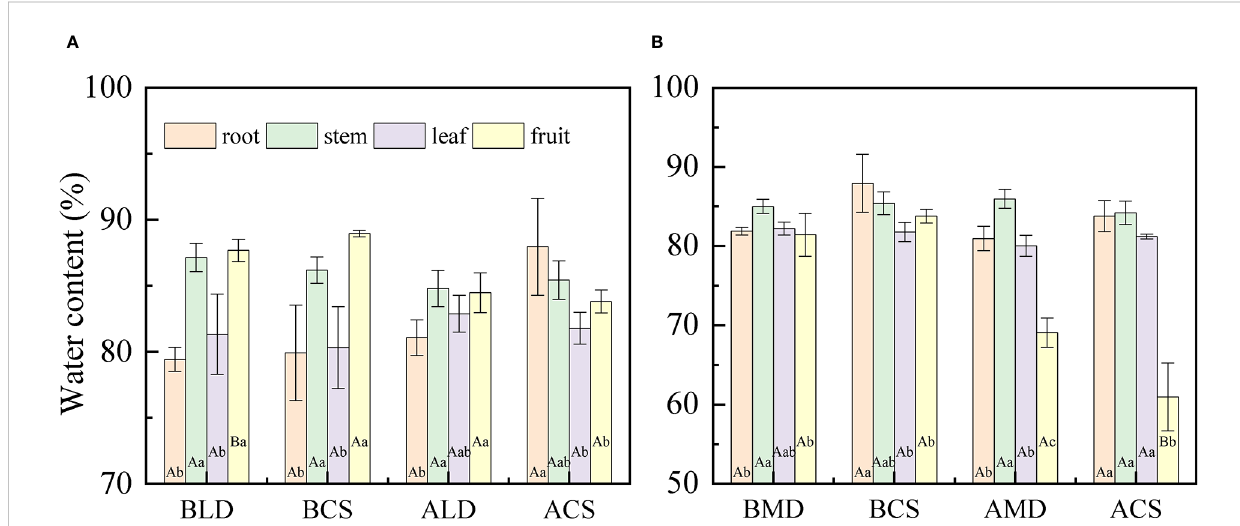
FIGURE 3 Comparative analysis of the water content of each component organ under different drought conditions and after rehydration. (A, B) are the comparative analysis of the water content of each component organ in light drought and moderate drought, respectively. Error bars represent standard deviations (n = 3), different capital letters indicate signi fi cant difference between groups (p< 0.05), and different lowercase letters indicate signi fi cant difference between different component organs of the same group (p< 0.05). BLD, BCS, ALD, and ACS represent before light drought, control group in the same period during light drought, after rehydration in light drought, and control group in the same period during after rehydration, respectively. Similarly, BMD, BCS, AMD, and ACS represent before moderate drought, control group in the same period during moderate drought, after rehydration in moderate drought, and control group in the same period during after rehydration, respectively.